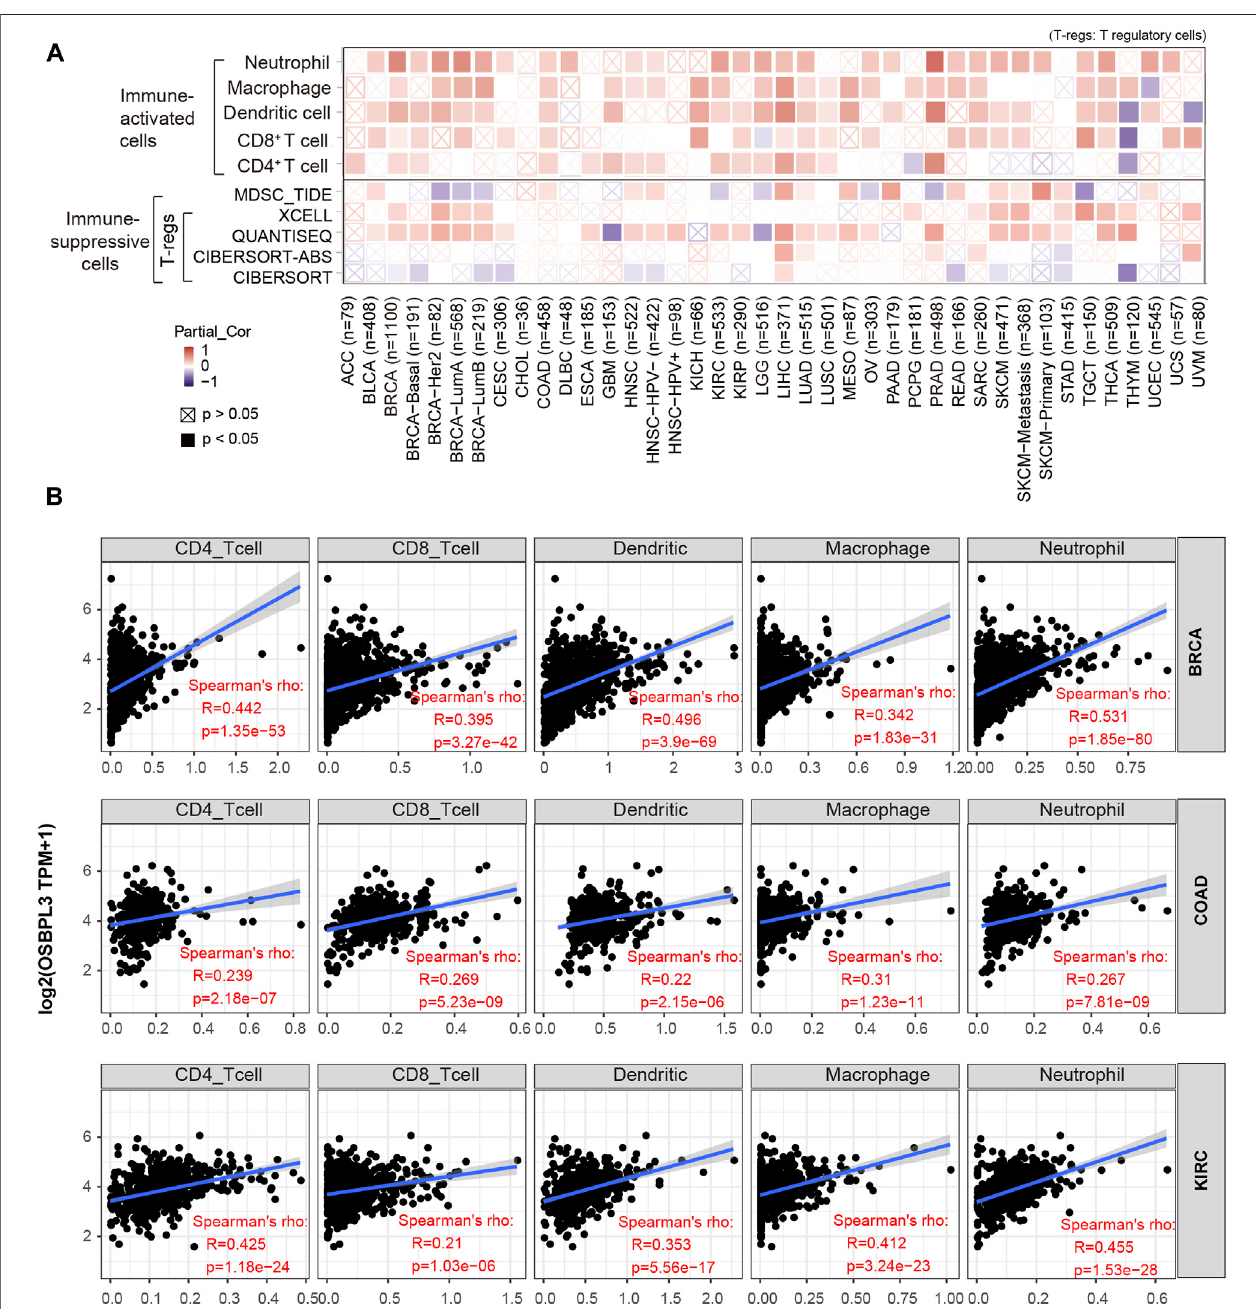
FIGURE 9 | Correlation analysis between OSBPL3 expression and immune cells. (A) Spearman correlation analysis heatmap of in fi ltration level of various immune cells and OSBPL3 gene expression in diverse tumor tissues (horizontal axis: different tumor tissues; vertical axis: different immune scores; different colors represent correlation coef fi cients; negative values represent negative correlations. The stronger the correlation, the darker the color. The Wilcox test was performed. * p < 0.05; ** p < 0.01; *** p < 0.001). (B) Correlation between the expression level of OSBPL3 gene and the in fi ltration level of CD4 + T cells, CD8 + T cells, dendritic cells, macrophages, and neutrophils in breast cancer (BRCA), colon adenocarcinoma (COAD), and kidney renal clear cell carcinoma (KIRC) (Spearman correlation analysis was performed).